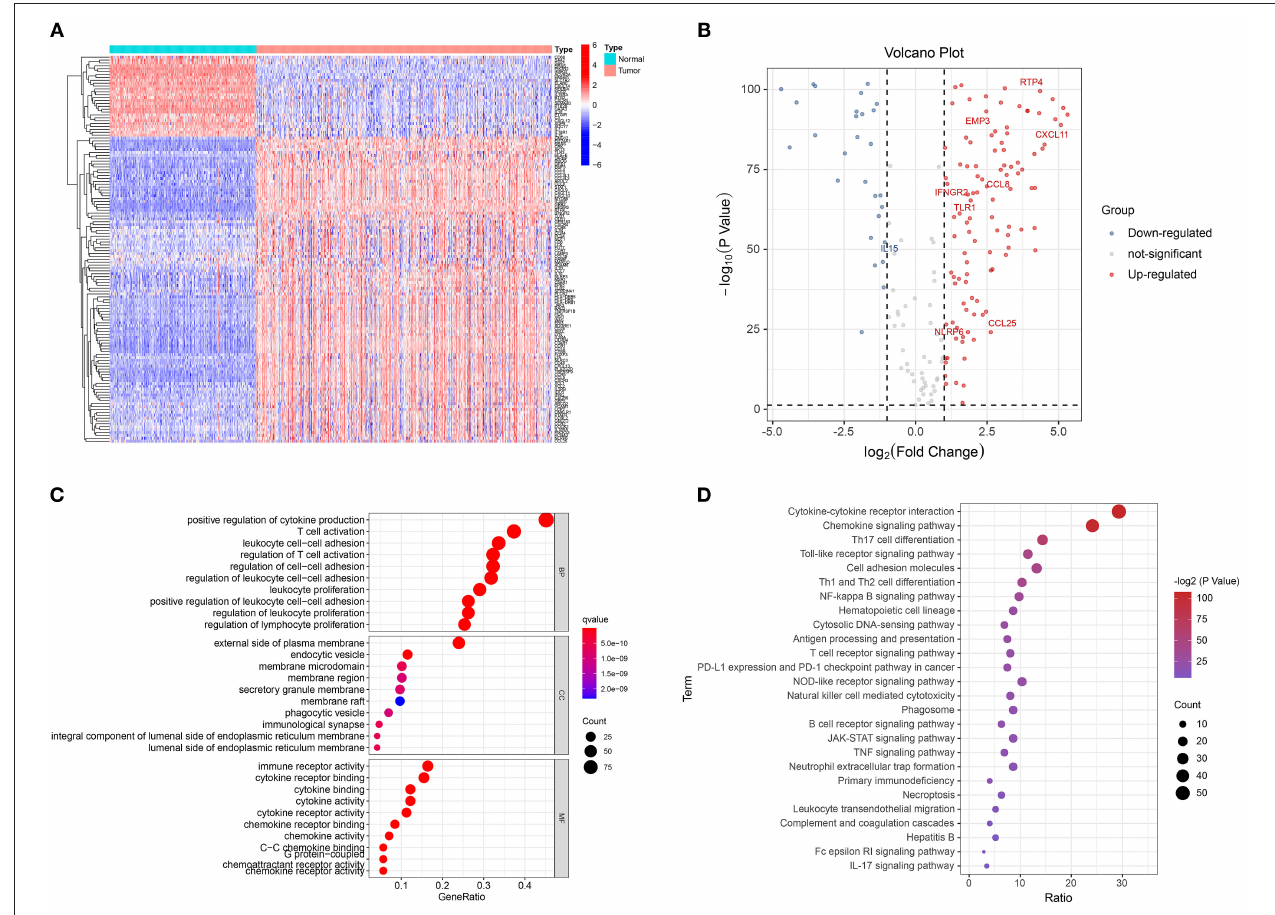
FIGURE 2 | Identification of differentially expressed GRIPs. (A) Heatmap of differentially expressed GRIPs. (B) Volcano plot of differentially expressed GRIPs. (C) GO enrichment analysis of differentially expressed GRIPs. (D) KEGG enrichment analysis of differentially expressed GRIPs.